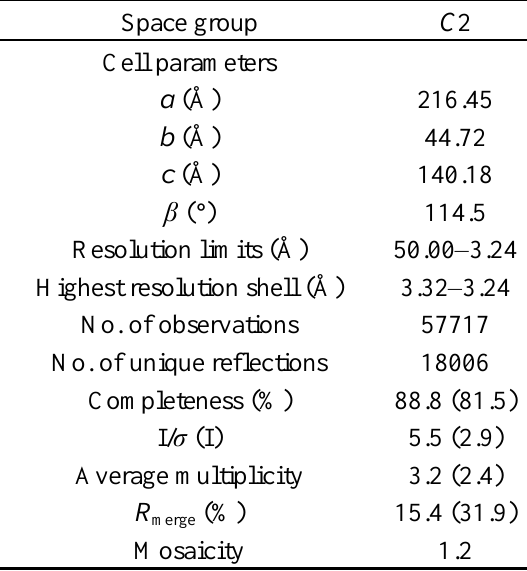
Table 2. Data collection